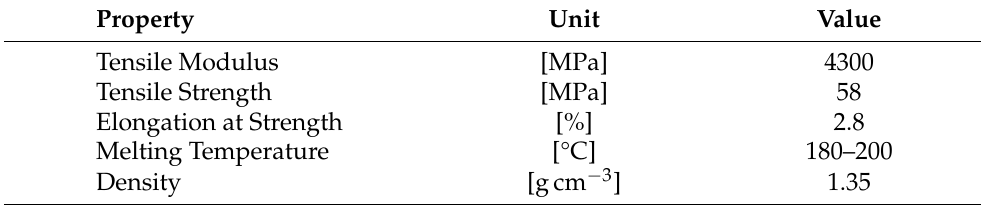
Table 1. Material properties of the used printing material GreenTEC Pro© [29].